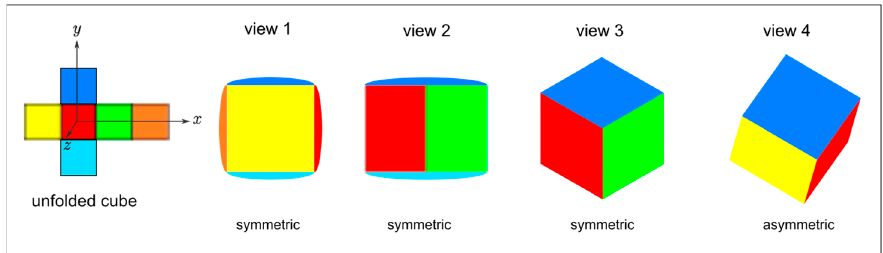
Figure 5. Revised learning exercise with restrictions in place.